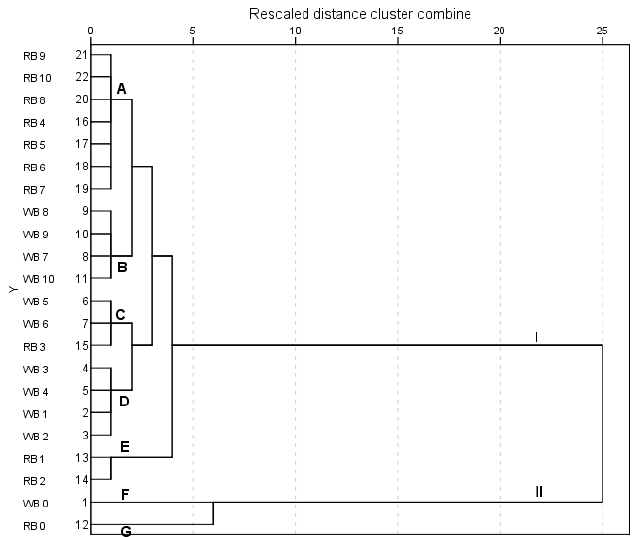
Figure 10. Clustering dendrogram of the indigenous sorghum beer samples at different fermentation times performed with hierarchical cluster analysis using the centroid method and squared Euclidean measurement. Notes: x-axis and y-axis mean the rescaled distance cluster and the beer samples measured, respectively. WB: white beer; RB: red beer. Arabic numerals (1 to 22) indicate time of fermentation. Beer samples sharing the same upper letter (A, B, C, D, E, F, G) and roman numeral (I, II) belong to the same sub-cluster and cluster